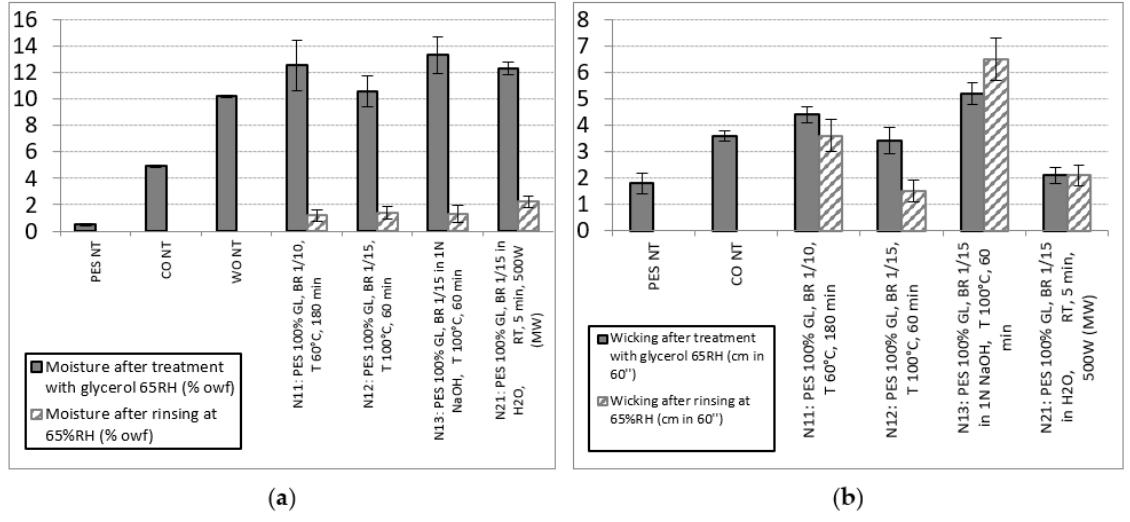
Figure 2. Moisture content at 65% RH ( a ) and wicking ( b ) of PES, CO and WO and the GL-treated PES fibers and after rinsing.